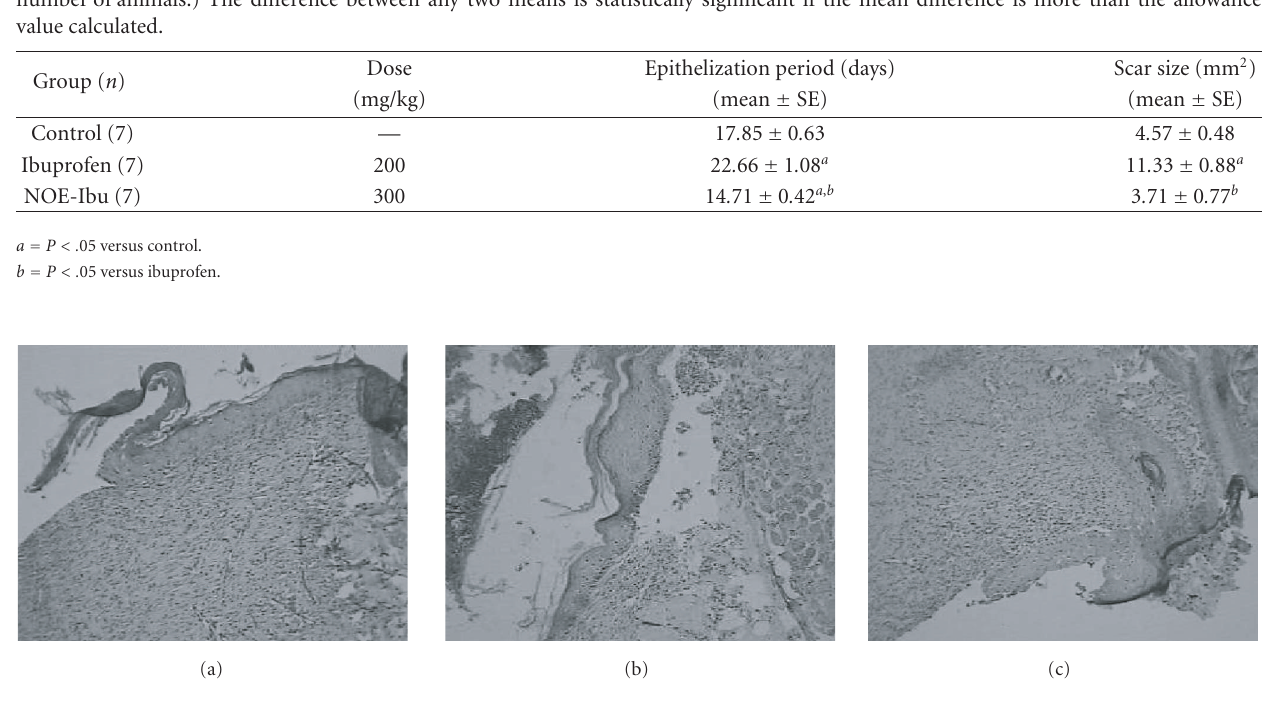
Figure 3: Photomicrograph showing granulation tissue interspersed with collagen (H&E × 100) of (a) control group, of (b) ibuprofen group, and (c) treated with